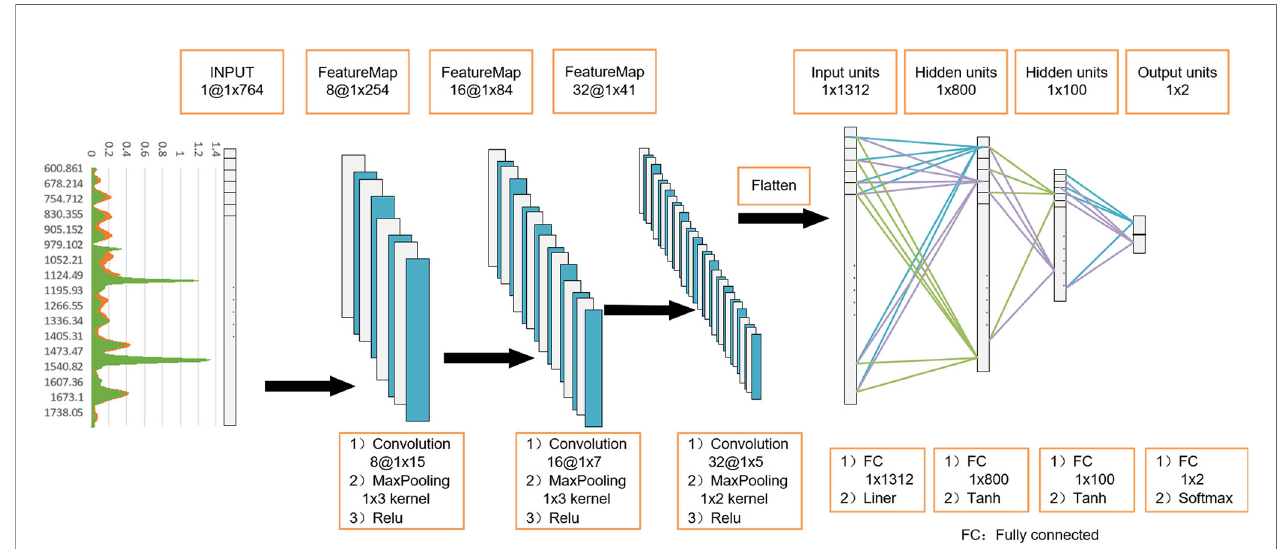
FIGURE 2 | One-dimensional convolutional neural network (1D-CNN) model architecture based on serum Raman spectra. Using 3-layer 1D convolution block, combined with fully connected neural network, construct a gastric cancer serum Raman spectrum discrimination